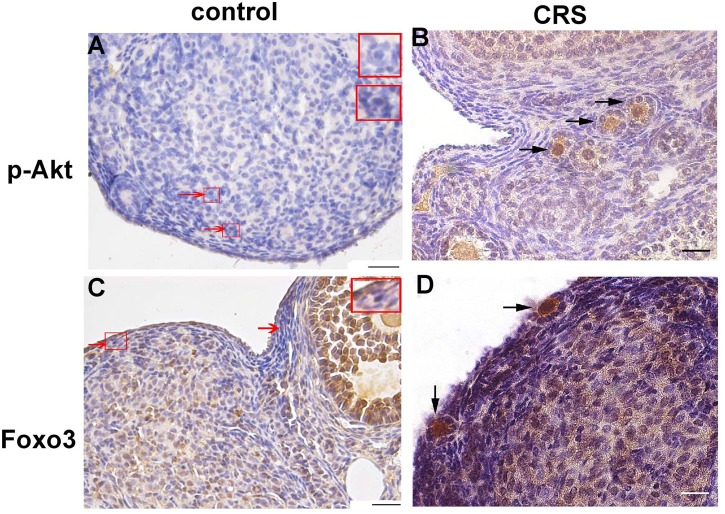
Immunohistochemical staining of pAkt and Foxo3 in the ovaries of the control and CRS 8w groups.The staining of pAkt and Foxo3 was obviously observed in the cytoplasm of oocytes in primary follicles of the CRS 8w group compared with that of the control group ((red arrows pointing to primordial follicles and black arrows to primary follicles; scale bar, 50 μm). CRS, Chronic restraint stress.